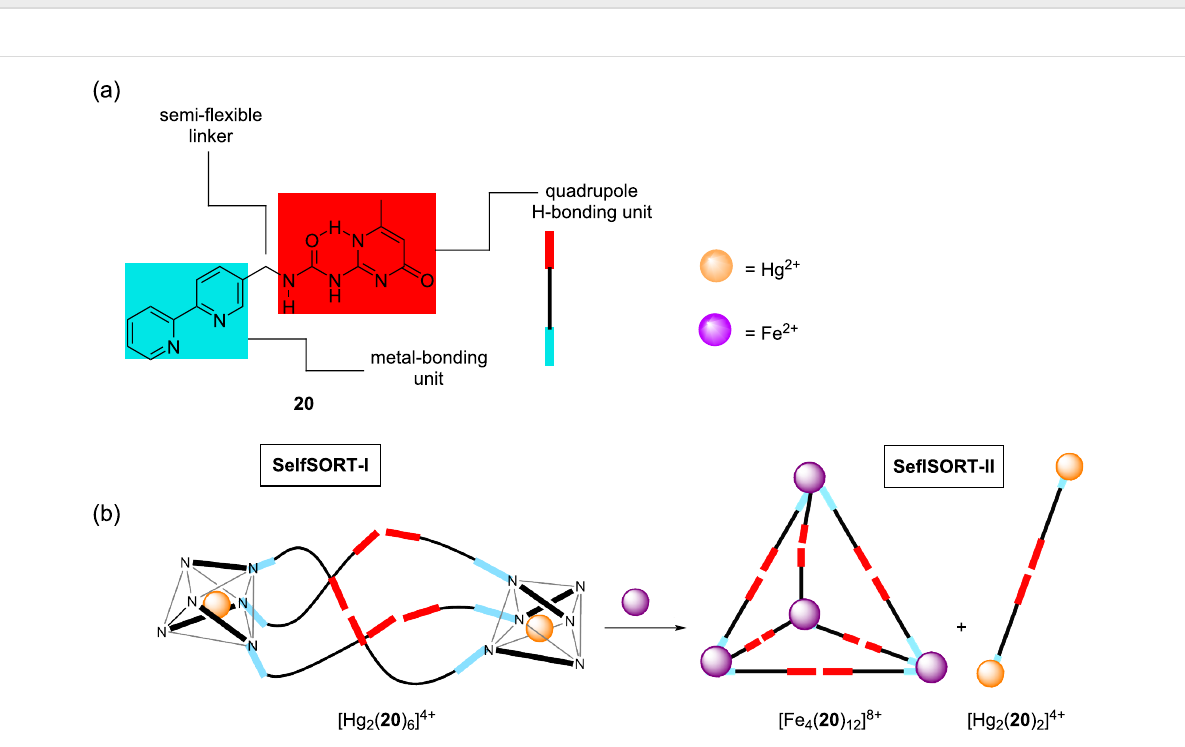
Figure 9: a) Chemical structure of the monomer 20 with its quadruple hydrogen-bonding array and a metal-affine 2,2’-bipyridine unit. b) Conversion of the helicate [Hg 2 ( 20 ) 6 ] 4+ to the S 4 -cage [Fe 4 ( 20 ) 12 ] 8+ and [Hg 2 ( 20 ) 2 ] 4+ based on double